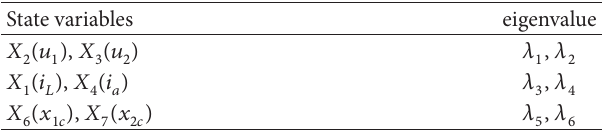
Figure 12: Real part of eigenvalues trace through homotopy method for FESS. Table 4: The correspondence between eigenvalues and state vari- ables.